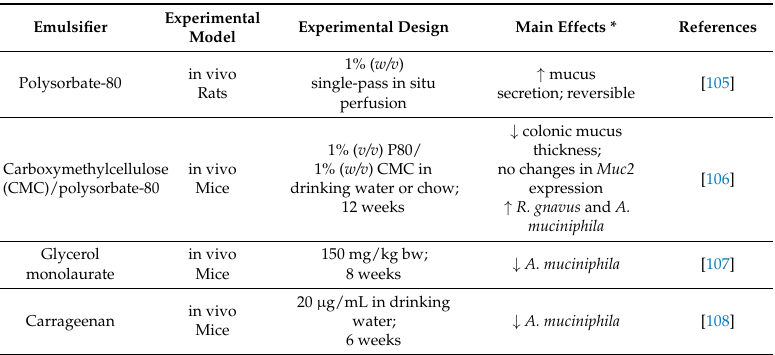
Table 4. Effects of emulsifiers on mucus and mucophilic bacteria in the